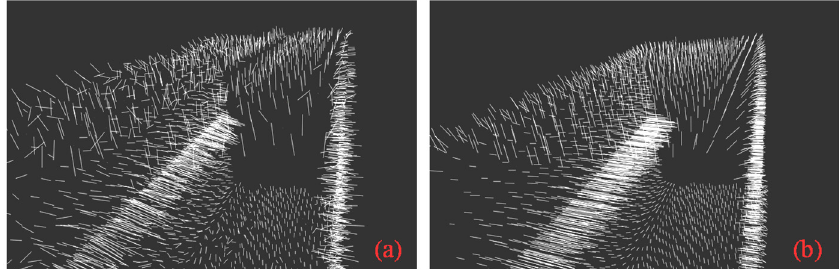
Figure 5. Normal vector of a cube point cloud. ( a ) is the normal vector obtained by MLS method; ( b ) is the normal vector obtained by proposed method.